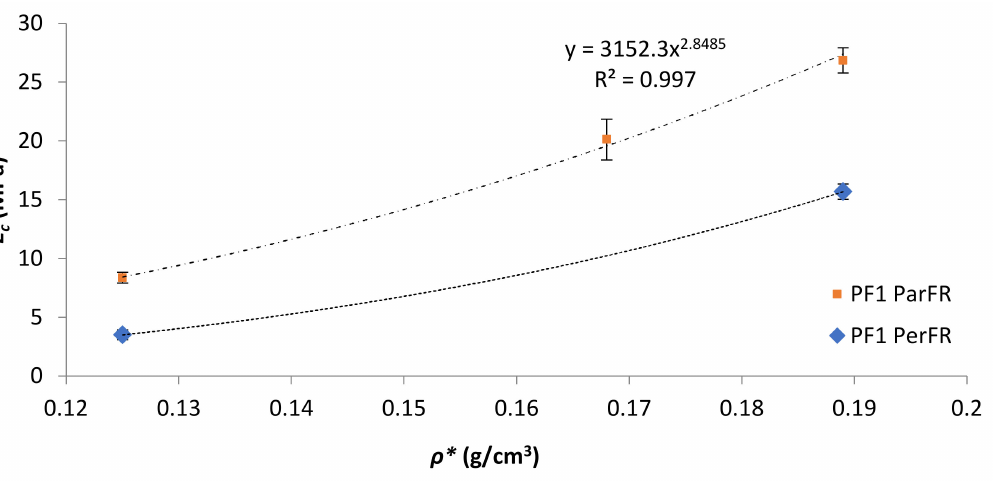
Figure 7. E c as a function of ρ * for